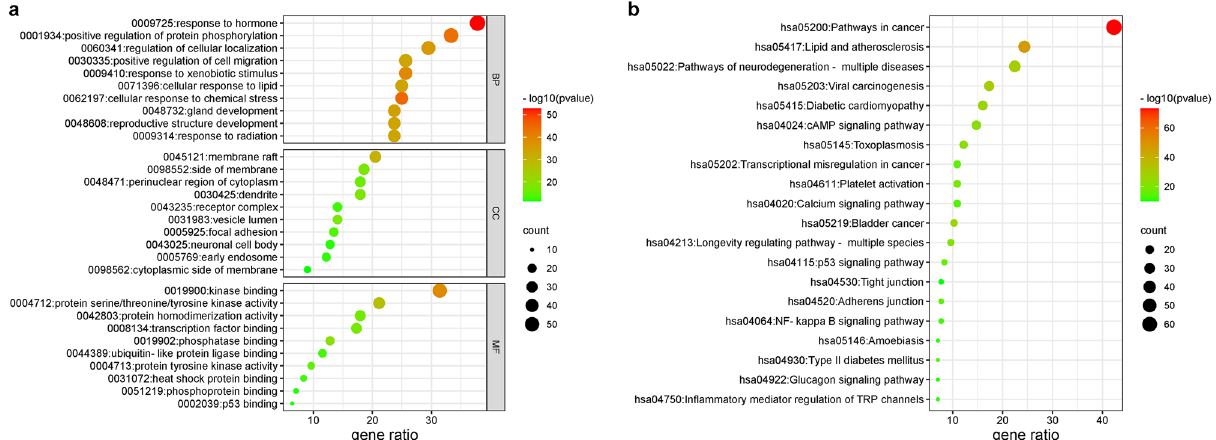
Figure 3. Enrichment analysis of GO and KEGG. ( a ) Top 10 biological processes, top 10 cellular compounds, and top 10 molecular functions: ( b ) top 20 KEGG pathways. The color scale indicates the different thresholds of p values and the size of the dots represents the number of genes corresponding to each